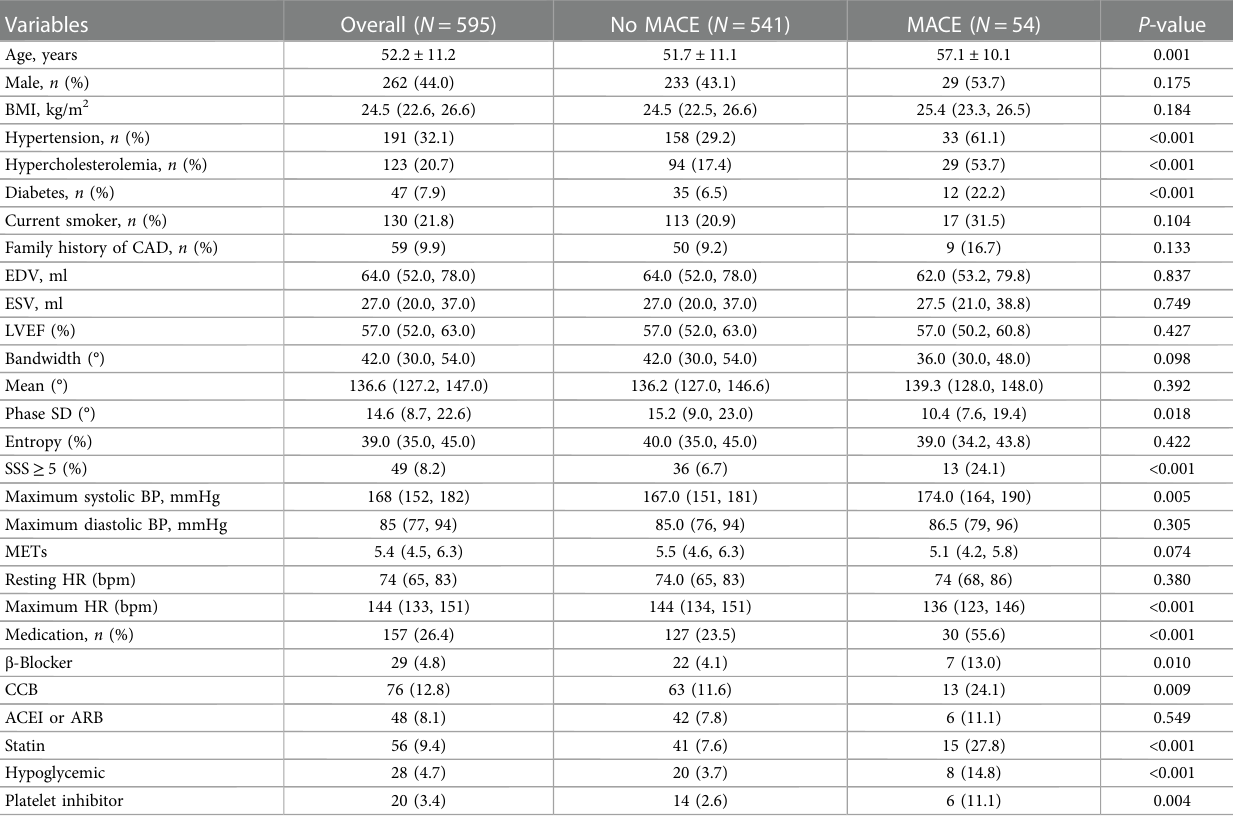
TABLE 1 Clinical characteristics and imaging fi ndings in 595 patients with suspected CAD undergoing exercise stress-MPS.